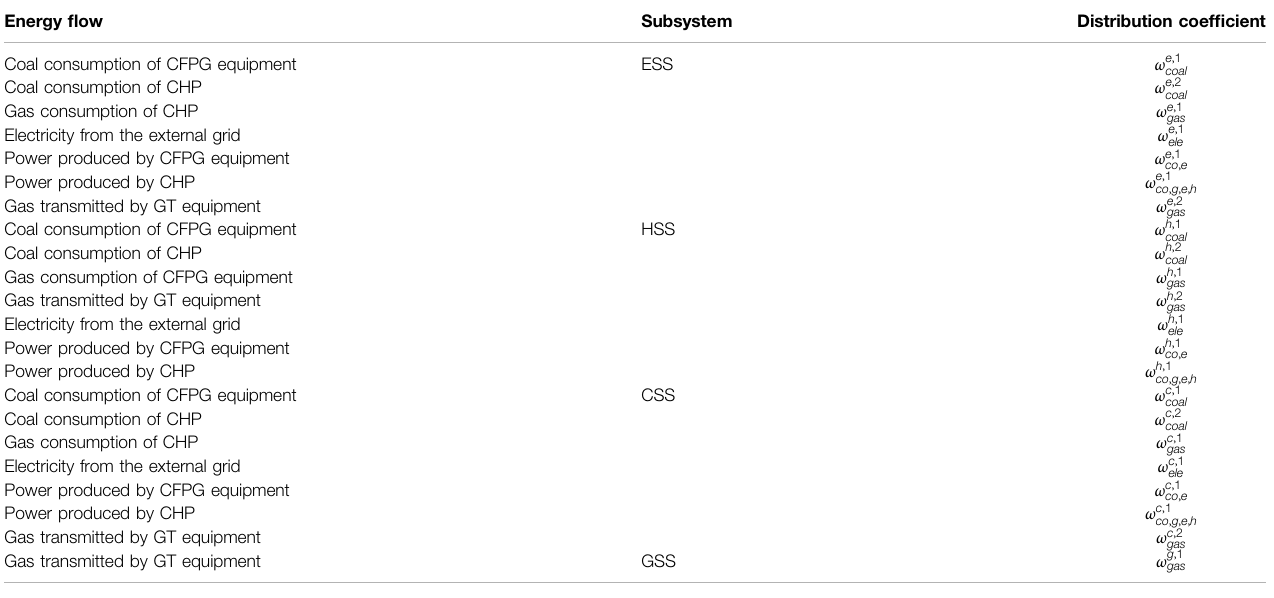
TABLE 1 | The distribution coef fi cient of each energy fl